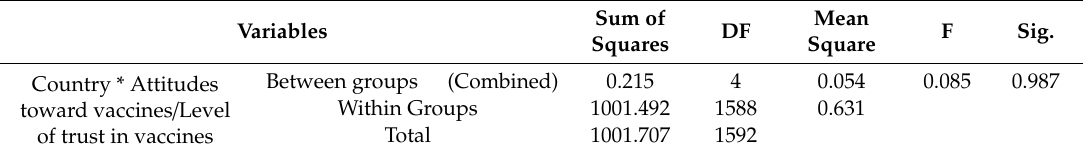
Mean Sum of F Sig. DF Square Squares